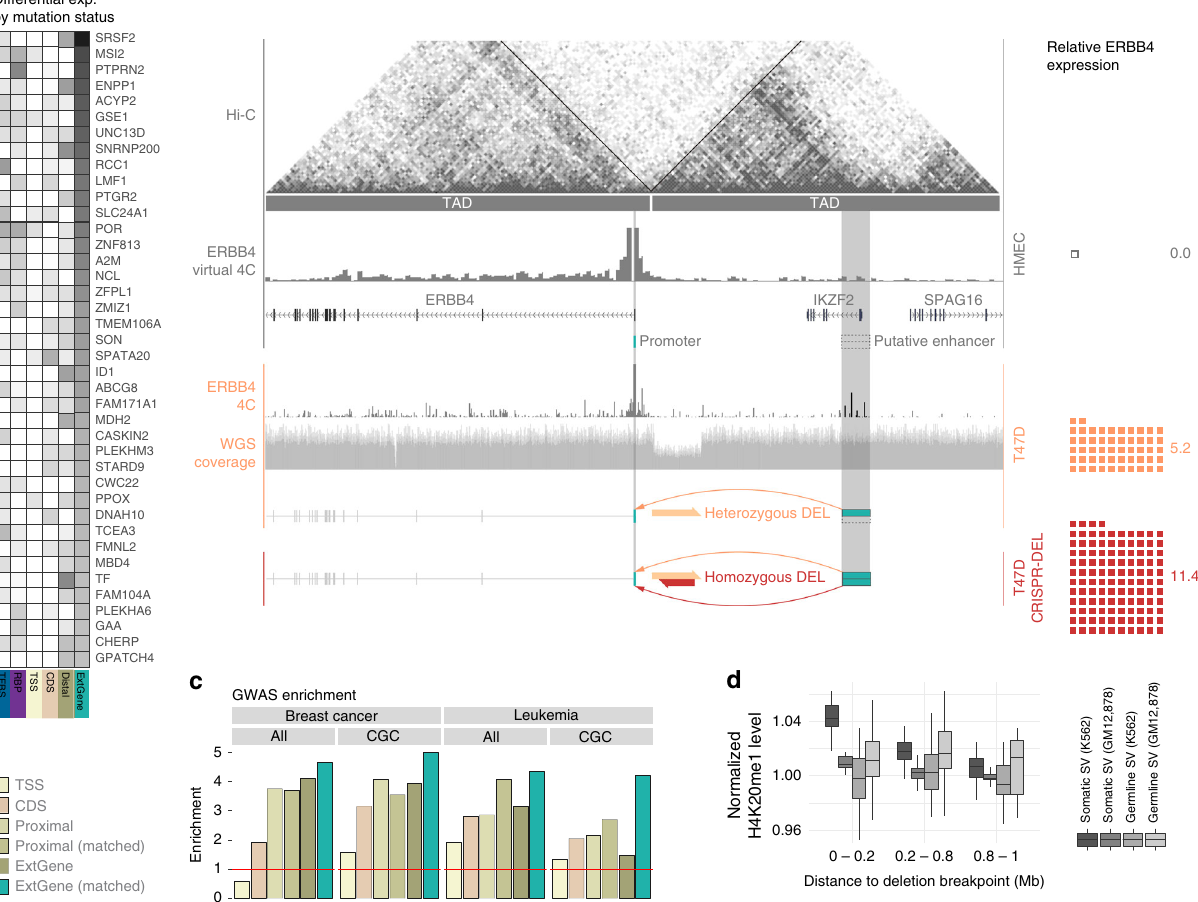
Fig. 5 Extended genes and mutation burden analysis. a Mutation status in extended genes can explain expression differences for a larger number of genes than other annotations, such as annotations of coding sequences (CDS). b A 130-kbp deletion in the breast cancer cell line T47D potentially links a distal enhancer to the promoter of ERBB4, leading to its activation. This change does not affect coding sequences, highlighting the value of an extended gene annotation. c Cancer-associated GWAS SNVs display greater enrichment with the inclusion of proximal and distal annotations in extended gene de fi nitions. d Somatic structural variant breakpoints in K562 tend to be associated with the activating histone mark H4K20me1, but not in